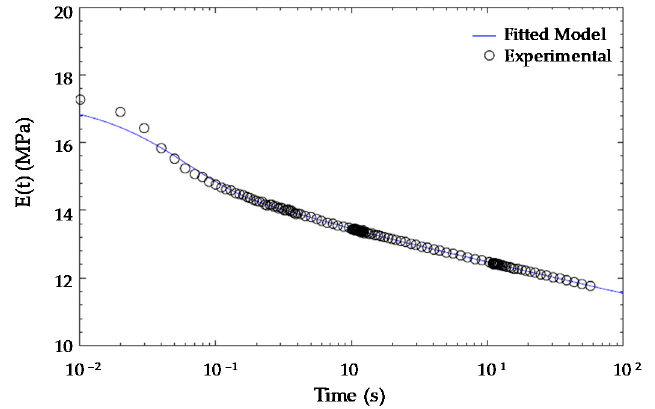
Figure 10. Generalized Maxwell model fitted and experimental relaxation modulus for the ID06 specimen.